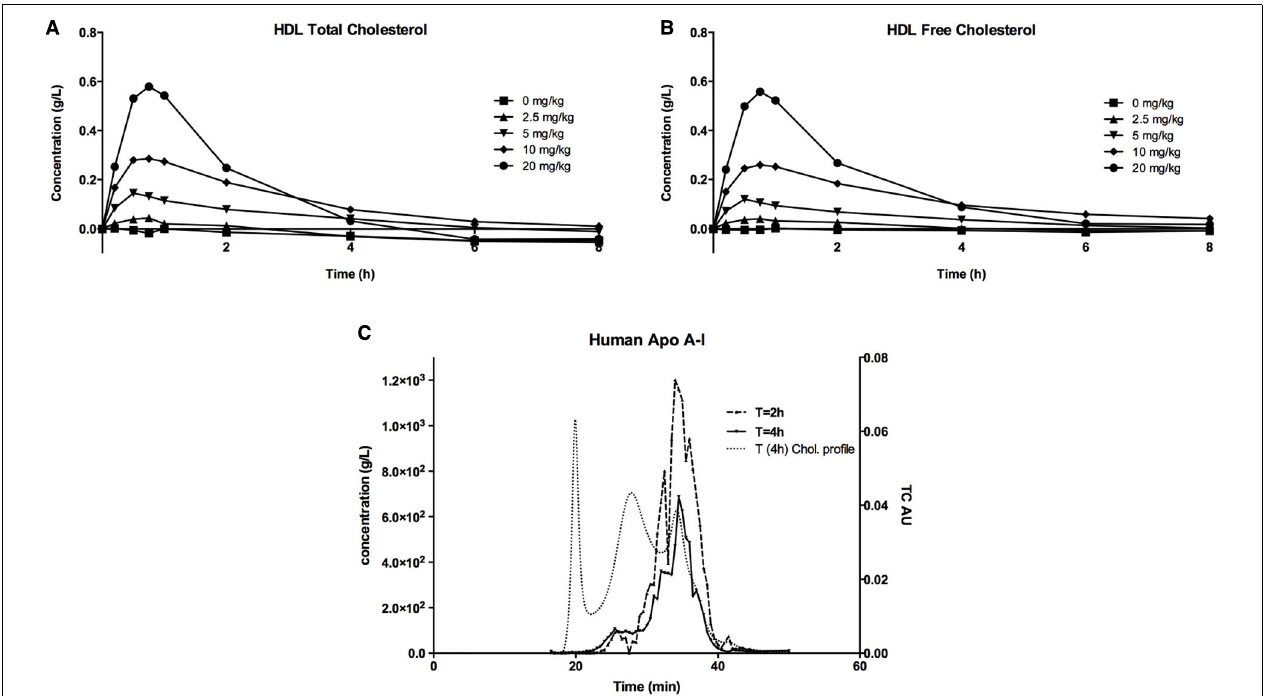
FIGURE 2 | Increase in plasma HDL (A) total cholesterol and HDL (B) unesterified cholesterol following infusion of CER-001. CER-001 was infused into fasted rabbits at doses of: 0 (squares), 2.5 (triangles), 5 (inverted triangles), 10 (diamonds), or 20 (circles) mg/kg. There were three animals per group. At various times post dose, plasma HDL total and unesterified cholesterol were measured. Baseline values were subtracted to determine the increase in plasma HDL cholesterol levels. Baseline HDL total and unesterified cholesterol ranged from 0.19 to 0.45 g/l for total and from 0.06 to 0.13 g/l for unesterified cholesterol. By 30–34 h post dose the values had returned to a value at or below baseline. (C) ApoA-I HPLC gel permeation chromatography profile. This is an example of an elution profile for human apoA-I at 2 h (dashed line) and 4 h (plain line) after infusion of CER-001 (20 mg/kg). Light dashed lines correspond to total cholesterol profile at 4 h. The elution times of 30 to 40 min correspond to the HDL fraction, while 18–22 min and 25–30 min correspond to VLDL and LDL,